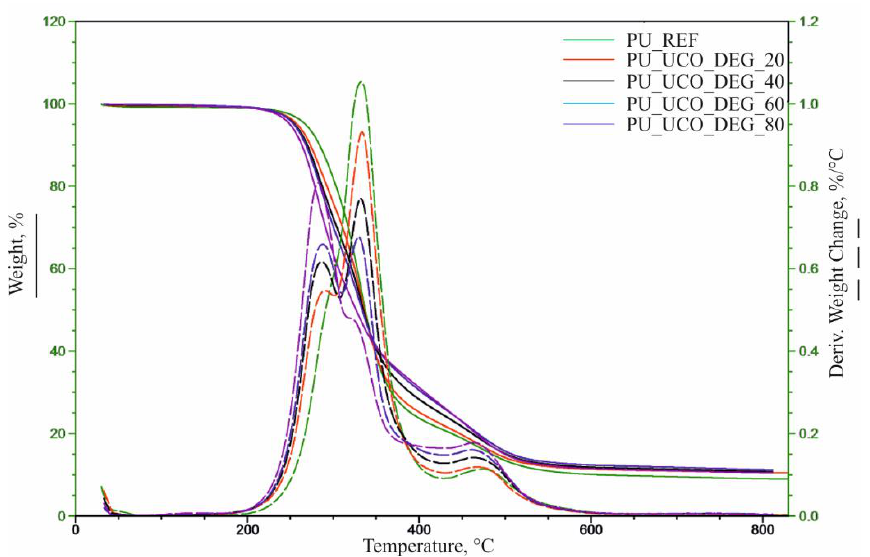
Figure 8. Thermograms for reference material and PU_UCO_DEG foams.